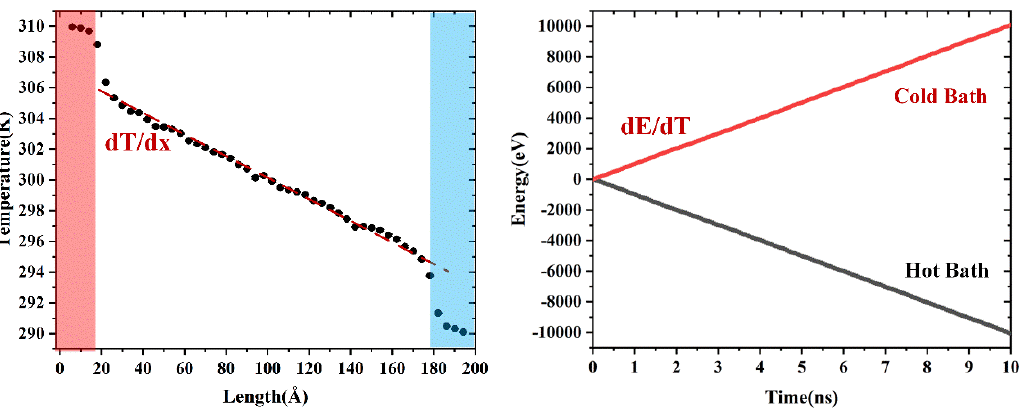
Figure 5. ( a ) Steady-state temperature profile of Gr without defect obtained using the NEMD simulations at 300 K. The color bars highlight the hot/cold bath in simulation. ( b ) Energies added to the hot bath and removed from the cold bath with respect to the time. Table 2. The TC and relevant values obtained by simulations or